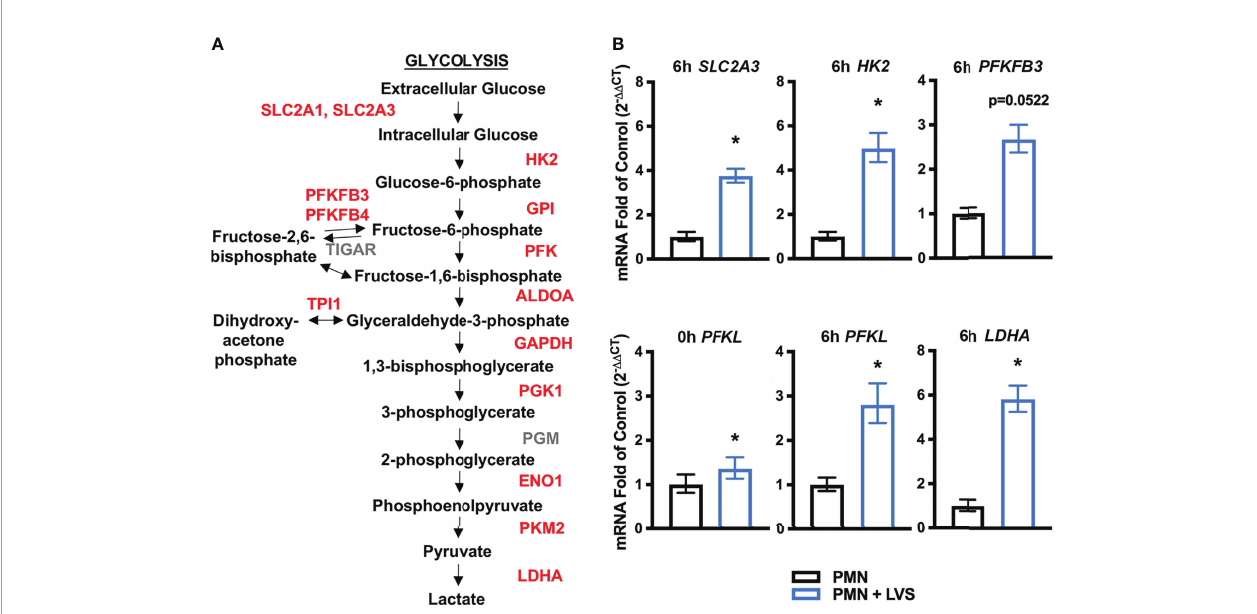
FIGURE 1 | LVS signi fi cantly upregulates PMN genes encoding glycolytic enzymes and glucose transporters. (A) Glycolysis pathway genes shown in red are signi fi cantly upregulated relative to uninfected cells by microarray analysis (22). (B) Validation of the microarray data by qRT-PCR analysis of SLC2A3 (6 hpi), HK2 (6 hpi), PFKFB3 (6 hpi), PFKL (0 hpi and 6 hpi), and LDHA (6 hpi), n=3, * p <